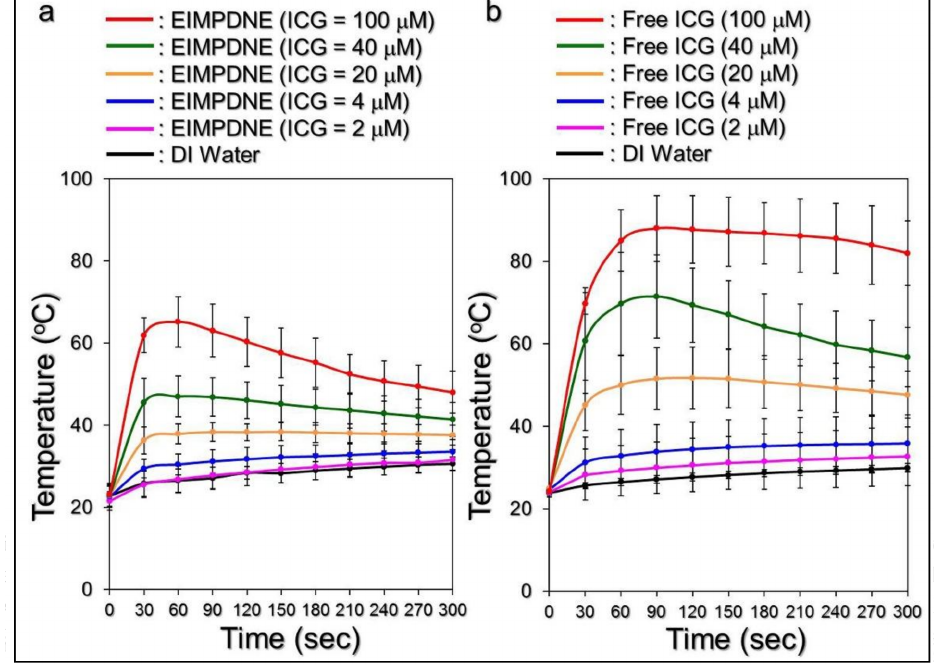
Figure 6. Assessments of EIMPDNE and freely dissolved ICG-induced hyperthermia effects under light illumination. Upon near infrared (NIR) laser irradiation (808 nm; 6 W cm − 2 ), the temperatures in the samples of EIMPDNEs ( a ) and freely dissolved ICG ( b ) with equal ICG concentrations of 0 (DI water only), 2, 4, 20, 40, and 100 µ M were separately measured using a digital thermometer every 30 s for 5 min. Values are mean ± s.d. ( n =